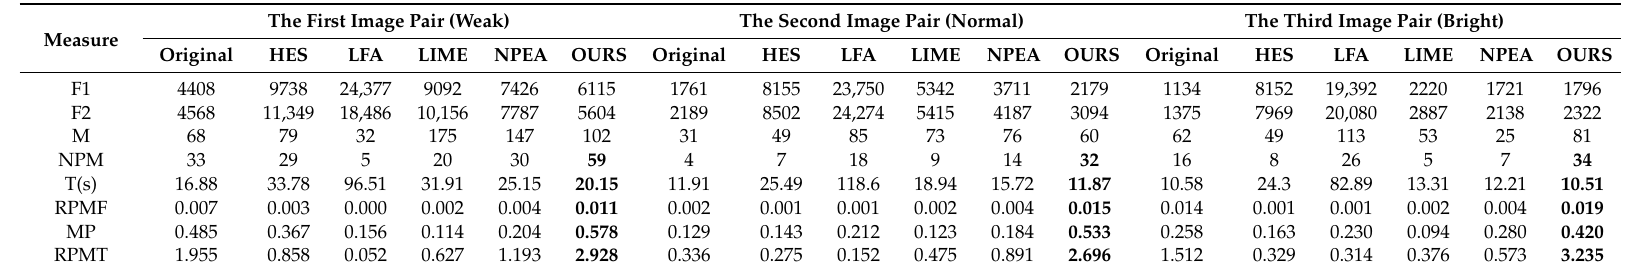
Table 3. Numerical performance indicators of SURF for the first to third image pairs.